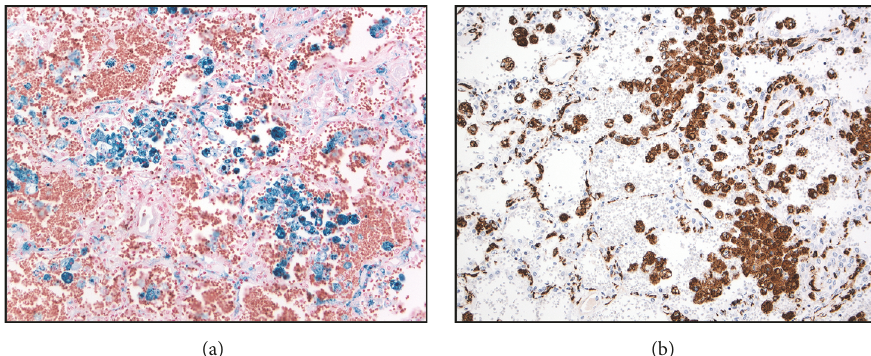
Figure 5: Area of lung with abundant hemosiderin-laden macrophages, singly and in clusters. (a) Prussian Blue stain confirming the presence of hemosiderin (blue). (b) CD68 immunostain demonstrating that the cells are macrophages (brown).